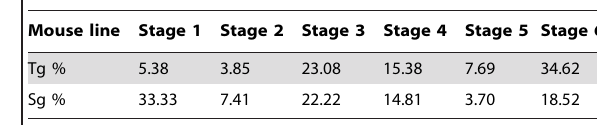
Table 2. Behavioural evaluation following KA